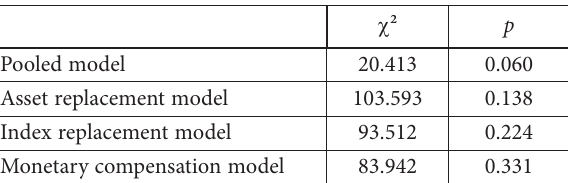
Table 3. Breusch–Pagan test for heterogeneous detection